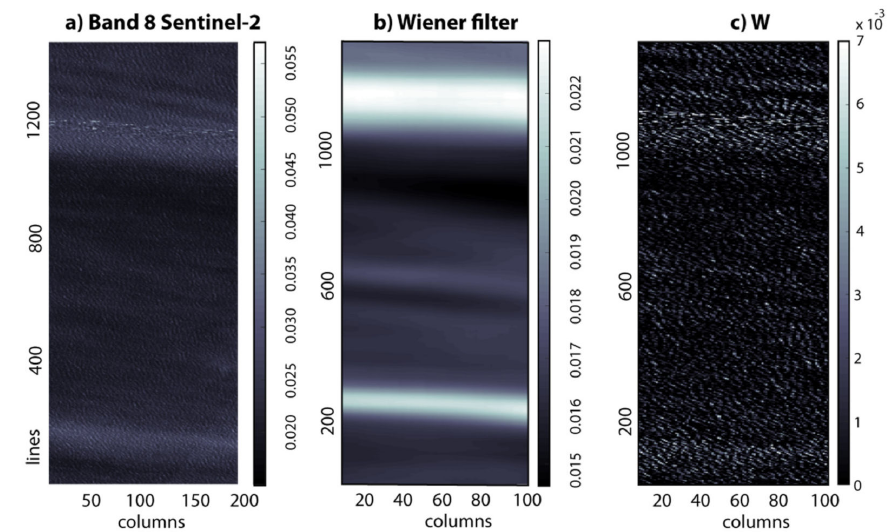
Figure 10. ( a ) Zoom as shown in the black rectangle in Figure 9b corresponding to the NIR Band 8 of the Multispectral Instrument (MSI) onboard the Sentinel-2A satellite on 21 April 2019 at 04 h 25 m UTC showing sea surface signatures of an ISW packet. ( b ) Wiener filter applied to the image in part ( a )—see text for details. ( c ) The image labeled W represents the wave breaking fraction, calculated by subtracting part ( b ) from ( a ).